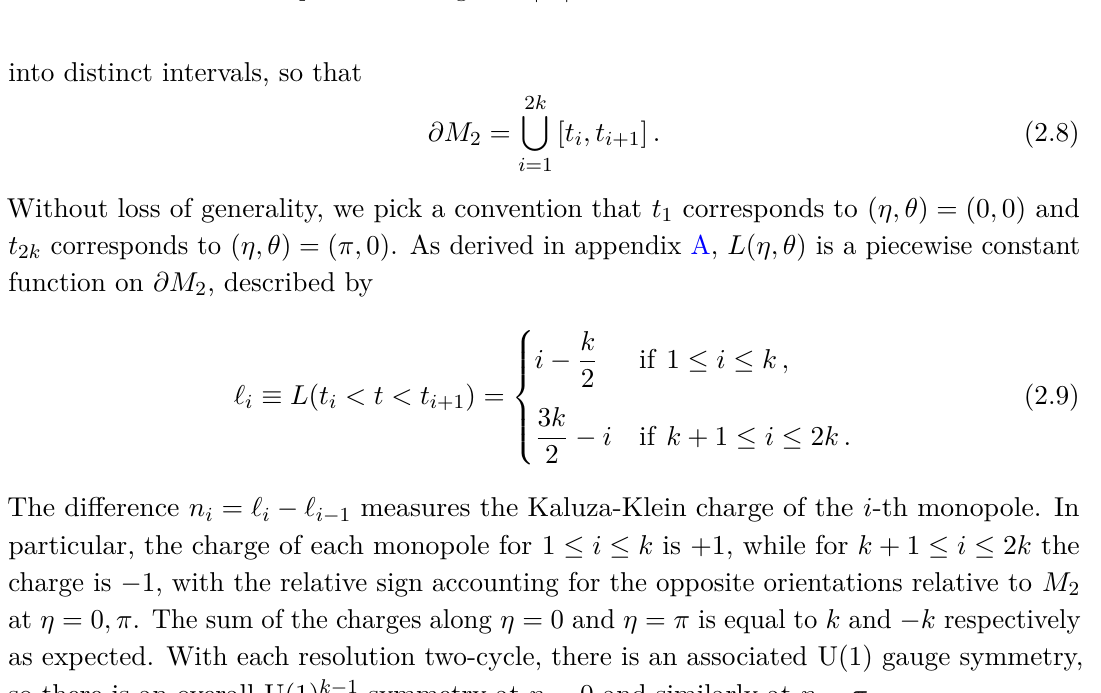
Figure 2 . An example of a partially resolved orbifold fixed point for k = 25 . Here we only show the interval corresponding to η = 0 . (There is an analogous situation at η = π with a generally different charge configuration.) Each number denotes the charge of the monopole above it, while each blue bubble represents a resolution two-cycle sandwiched between two unit-charge monopoles. Note that there is no two-cycle adjacent to any monopole whose charge is greater than one. There is a U(1) gauge symmetry associated with each two-cycle, and an enhanced SU( | n i | ) gauge symmetry associated with each monopole with charge 1 ≤ | n i | ≤ k